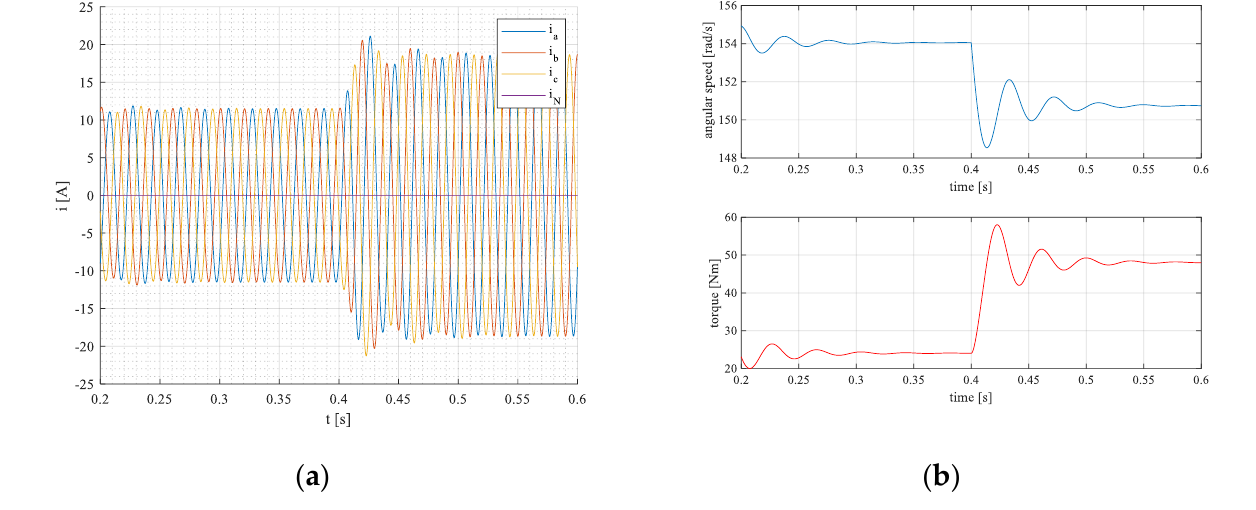
Figure 7. Phase voltages ( a ), currents ( b ) in 𝑎, 𝑏, 𝑐 — coordinates. Apparent, active, blind, and distortion powers during the transient state are in Figure